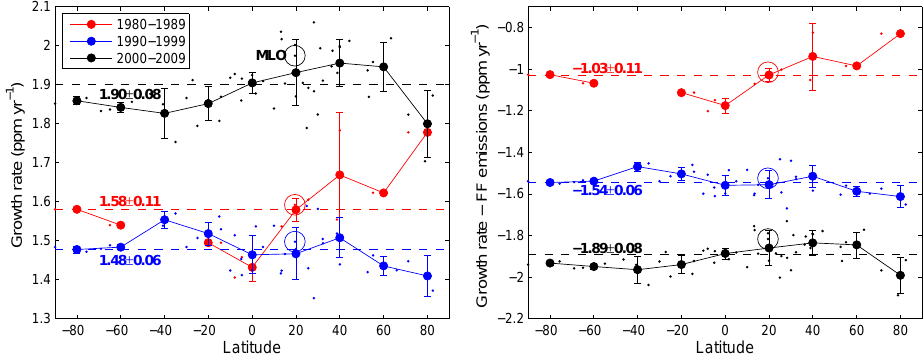
Figure 5. Decadal mean CO 2 growth rates inferred from individual site measurements and averaged in 20 ◦ latitude bins having retained (left) and subtracted (right) the decadal mean global fossil fuel emissions (CDIAC). The solid line with error bars represents the decadal mean growth rate in each latitude bin with ± 1 σ representing the standard deviation between individual sites in that latitude bin. The global decadal mean growth rate is indicated by the dashed lines and mean values with ± 1 σ representing the standard deviation between all sites. Values for MLO, which are typically taken to be representative of the global growth rate, are highlighted with a circle. Time series of annual growth rates were determined for individual CO 2 measurement sites before calculating decadal mean growth rates and then binning the decadal mean growth rates into 20 ◦ latitude bins. We subtract a global mean growth rate due to fossil fuel combustion from all sites.